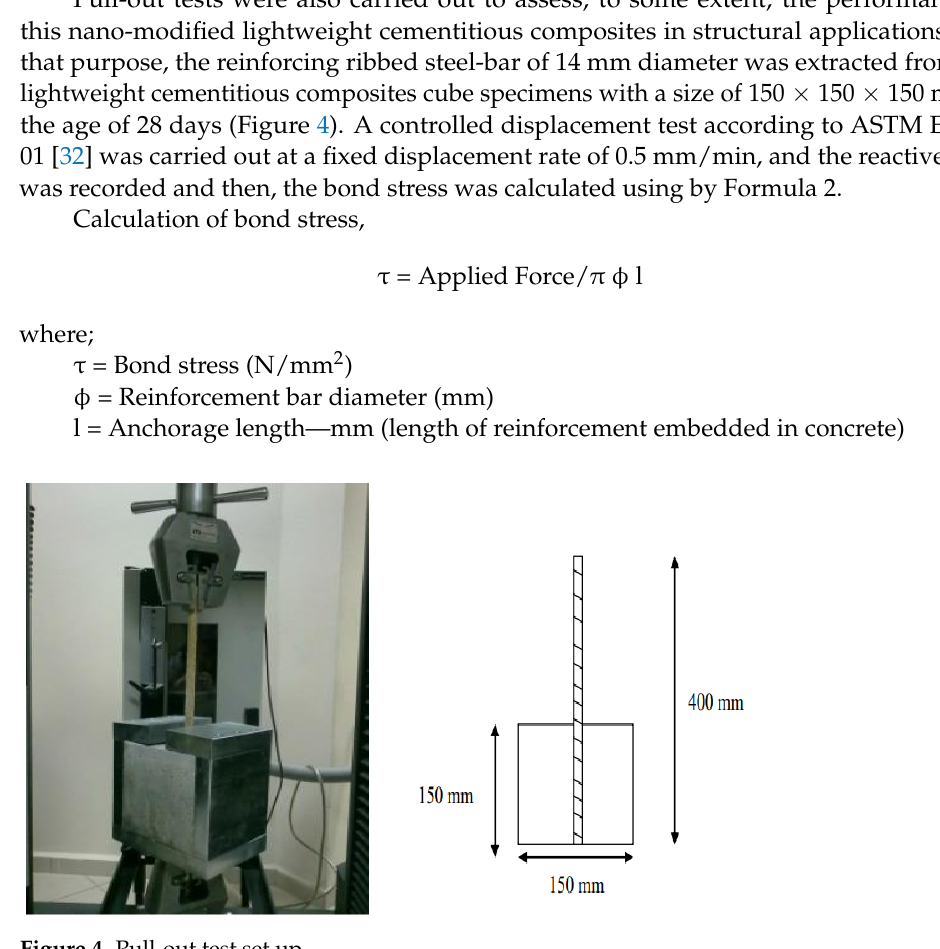
Figure 4. Pull-out test set